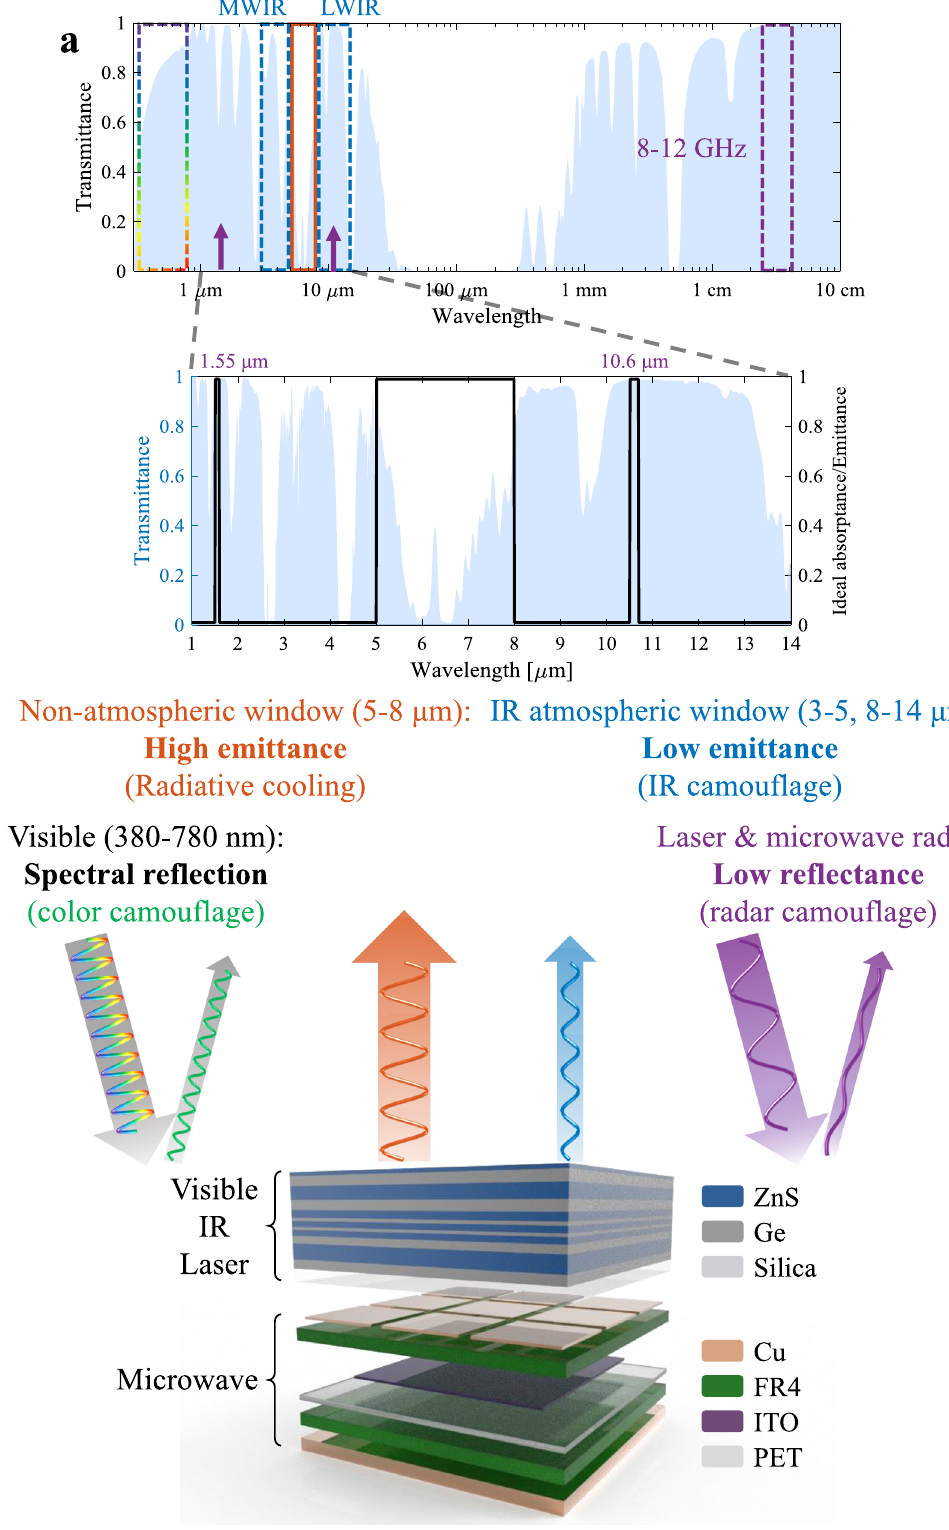
Fig. 1 Atmosphere transmittance and scheme for multispectral camou fl age. a Atmosphere transmittance spectrum for the electromagnetic wave (from visible to microwave) with detectable ranges indicated by dashed boxes and arrows. The IR part (1 – 14 μ m) is magni fi ed and shown with the ideal absorbance/emittance spectrum. b Requirements of multispectral camou fl age for each respective range, and the designed structure with ZnS/Ge multilayer selective emitter for visible, IR, and laser camou fl age and Cu-ITO-Cu absorptive metasurface for microwave camou fl age.